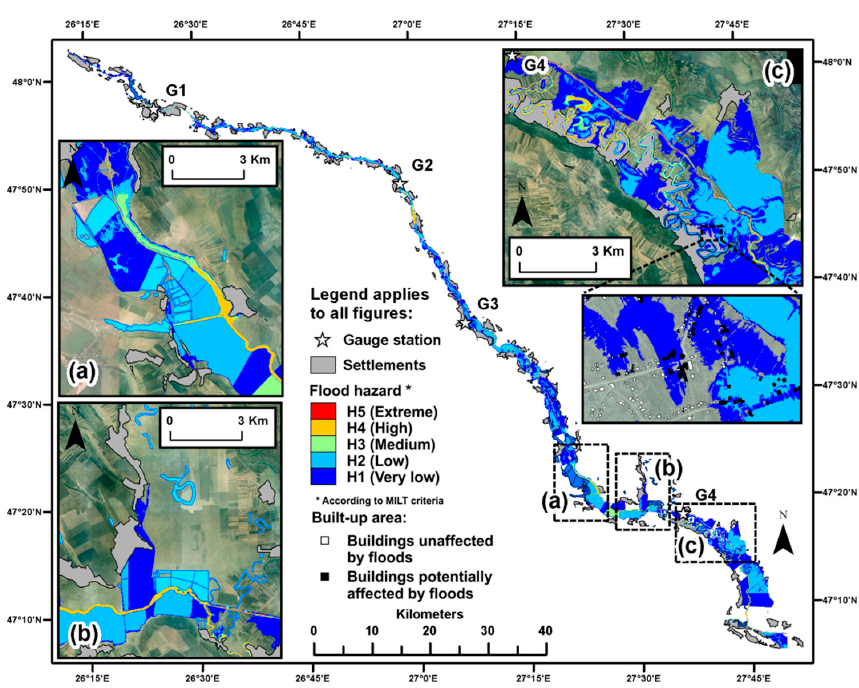
Figure 8. Flood hazard pattern based on flood depth classification according to the MILT criteria. Data derived from 1D HEC-RAS modeling based on LiDAR data (0.5 m spatial resolution) and Q max . (m 3 /s) flow rates with 1% (100-year) recurrence interval estimated for each gauging station (G1, G2, G3 and G4). The 1% (100-year) flood hazard pattern is highlighted for sections ( a – c ).